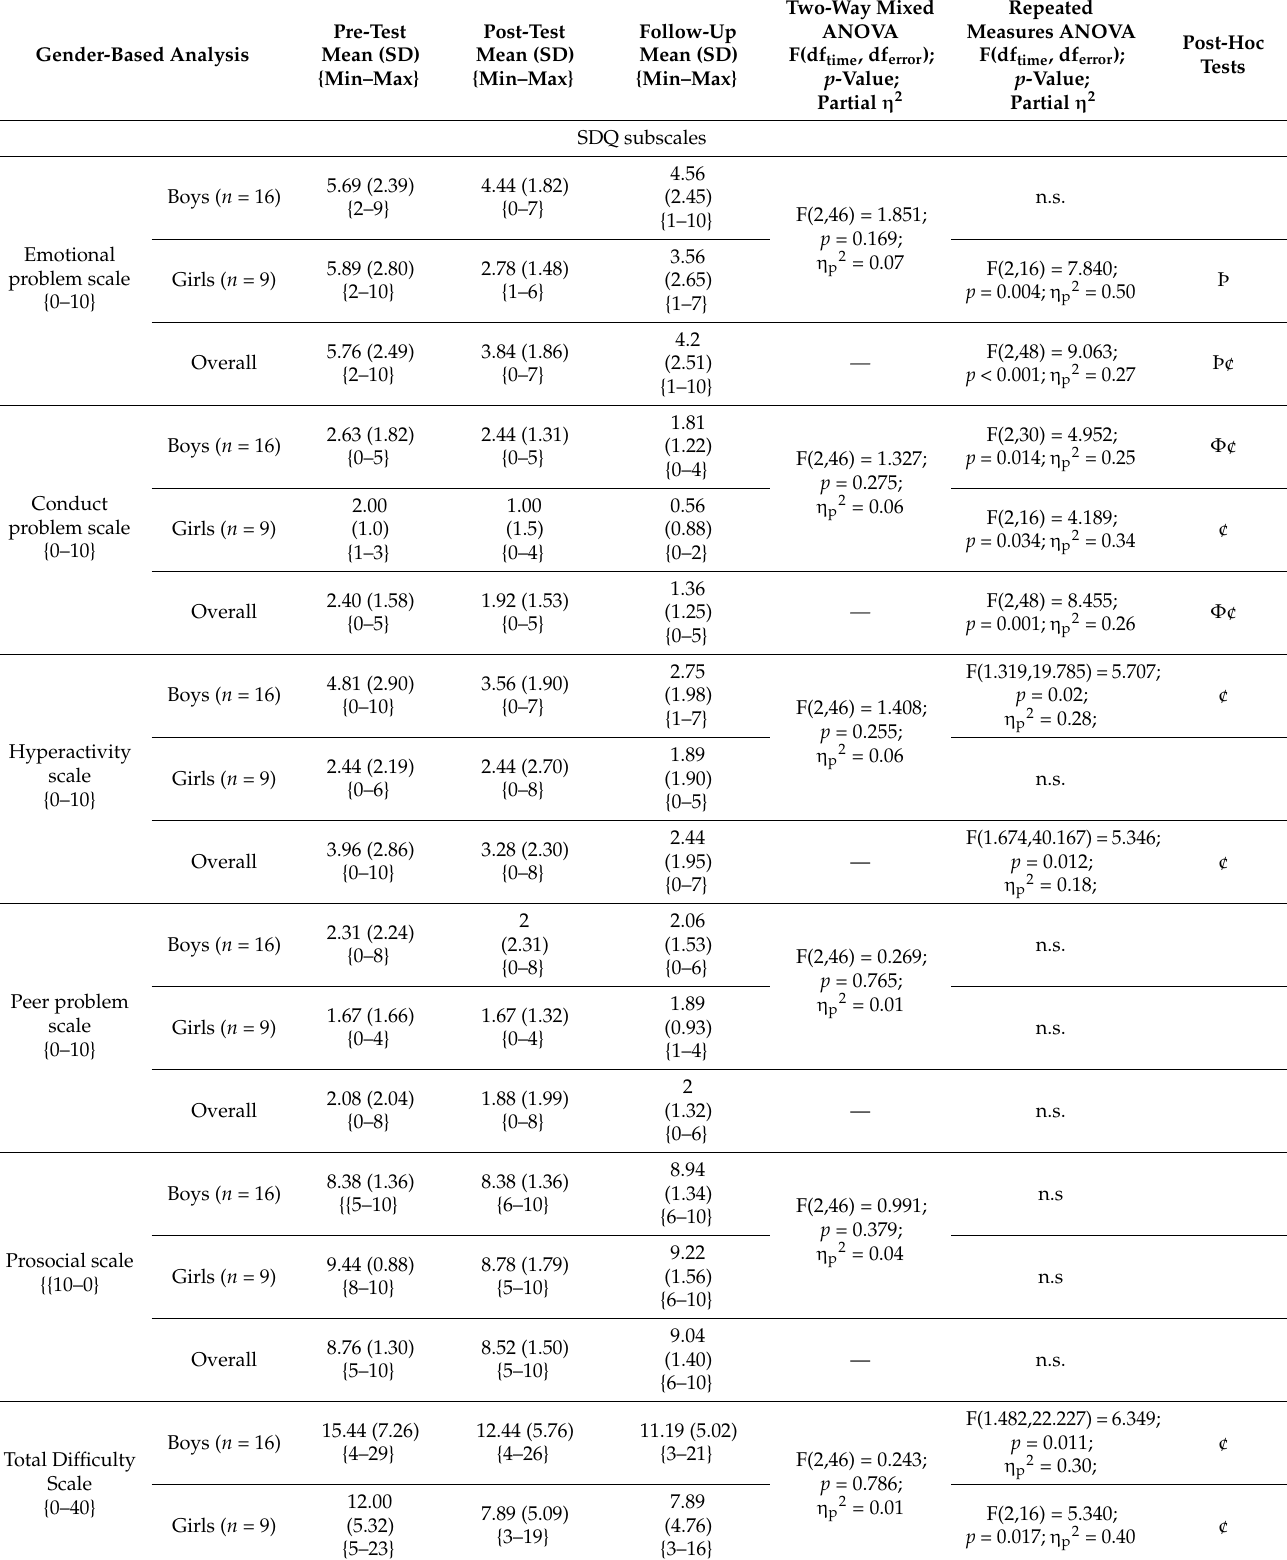
Table 1. Differences in scores of the Strengths and Difficulties Questionnaires before the intervention (Pre-test; t1), two weeks after the intervention (Post-test; t2) and six weeks after completion (Follow-up; t3) between girls and boys and those with very high (20–40 points) or high (17–19 points) scores on the total difficulty